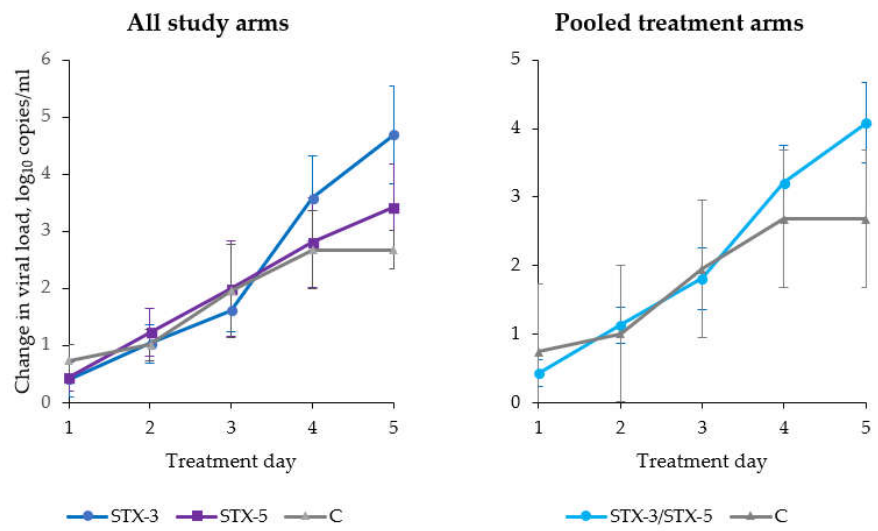
Figure 3. Absolute change in viral loads in intention-to-treat (ITT) population by excluding subjects with high baseline viral loads ( n = 15), by study arm and day of treatment (vertical bars represent standard errors).